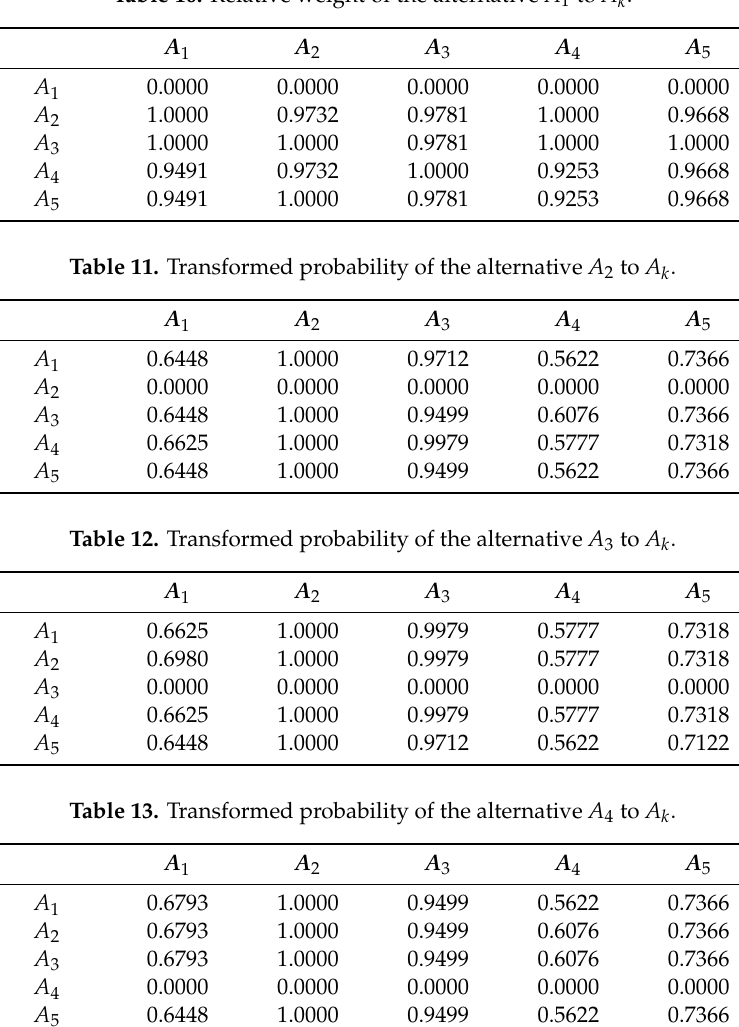
Table 10. Relative weight of the alternative A 1 to A k .